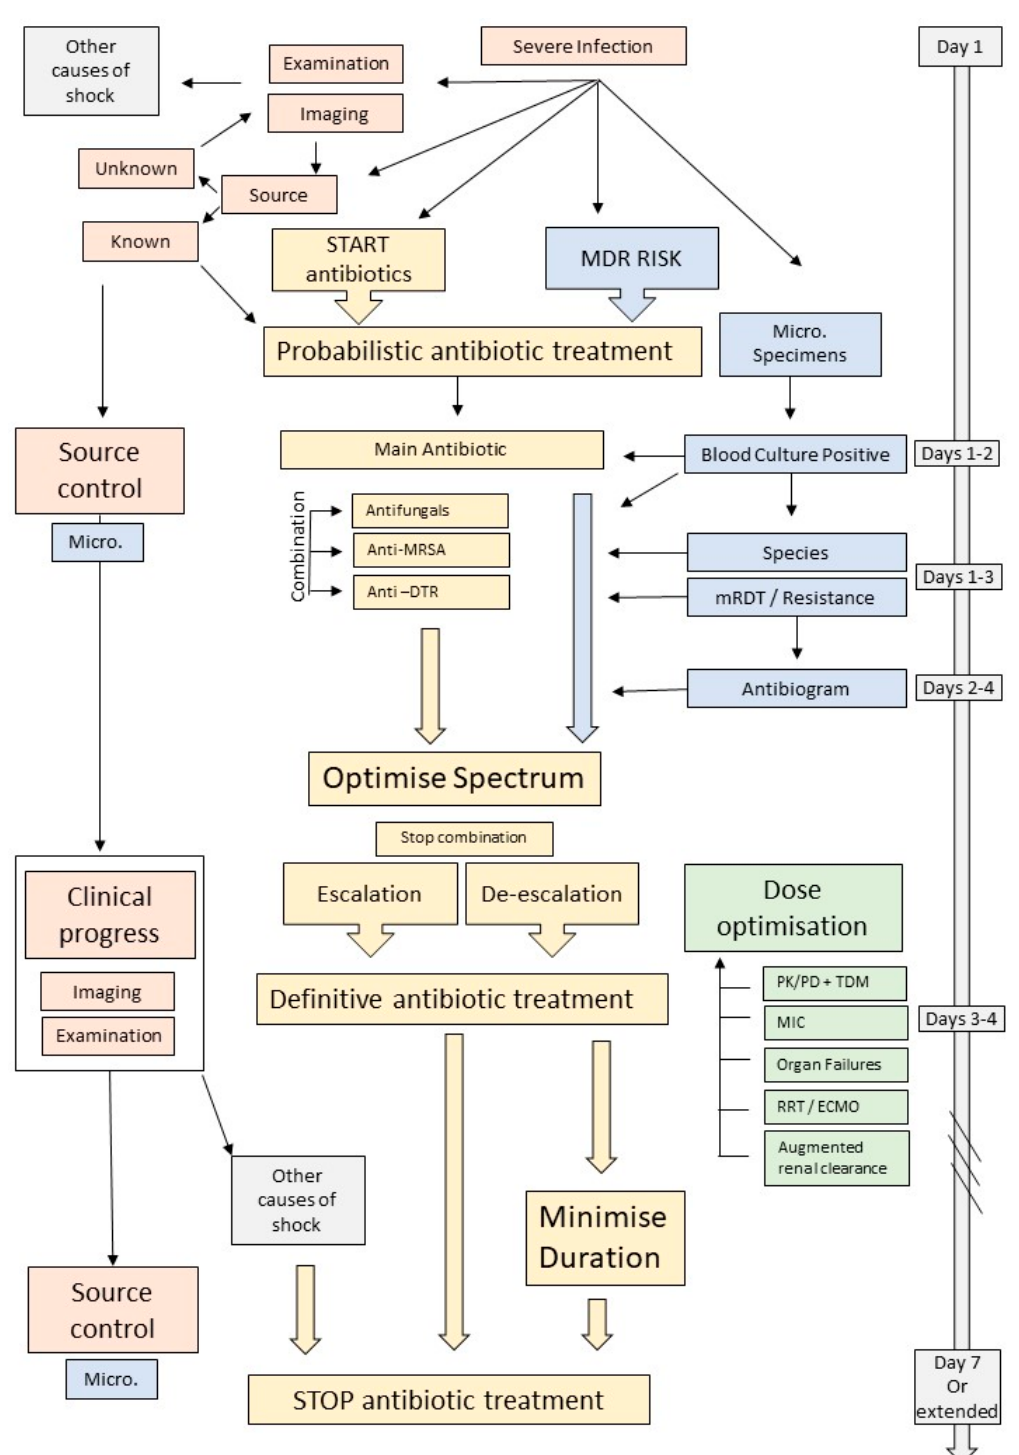
Figure 1. Management of an ICU patient with a blood stream infection. mRDT = molecular rapid diagnostic testing, Micro. = microbiology specimens, MDR = multidrug resistant, DTR = difficult-to- treat resistance, MRSA = methicillin-resistant Staphylococcus aureus.